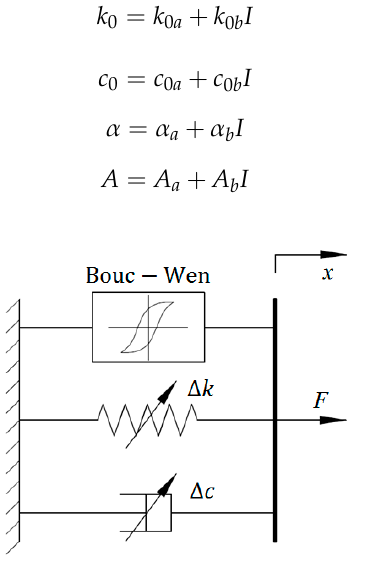
Figure 4. Bouc–Wen model.